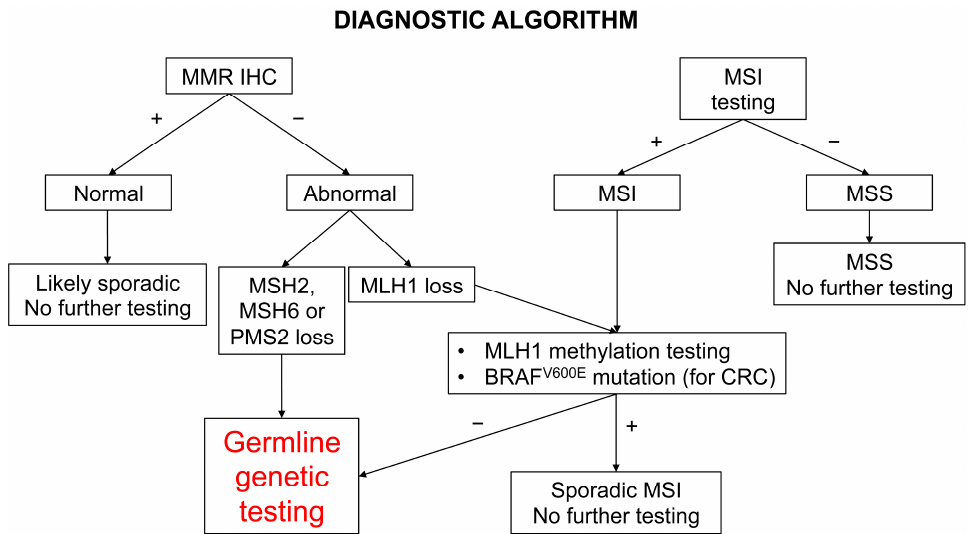
Figure 4. The diagnostic algorithm for colorectal (CRC) and endometrial cancer. MMR deficiency can be tested with immunohistochemistry (IHC) for MLH1, MSH2, MSH6, and PMS2 or MSI testing, complemented by MLH1 promoter methylation testing, and BRAF mutation analysis for CRCs.